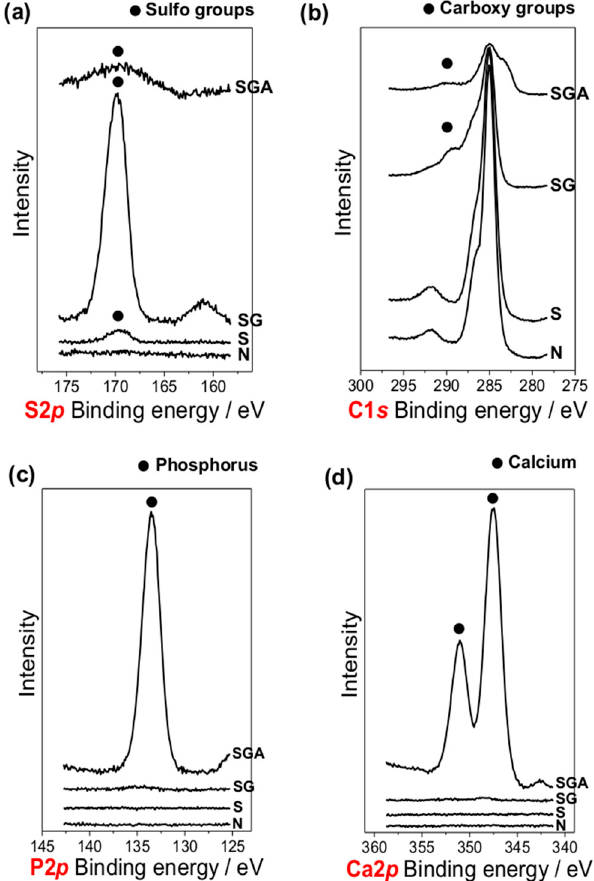
Figure 2. XPS narrow spectra around binding energy of ( a ) S2 p , ( b ) C1 s , ( c ) P2 p and ( d ) Ca2 p on the surface of Samples N, S, SG and SGA.